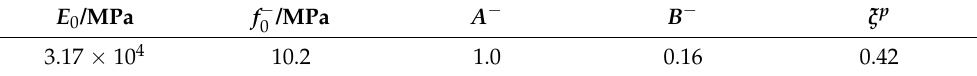
Table 2. Simulation parameters of uniaxial compression test. Table 2. The comparison between the numerical simulation results and test results is